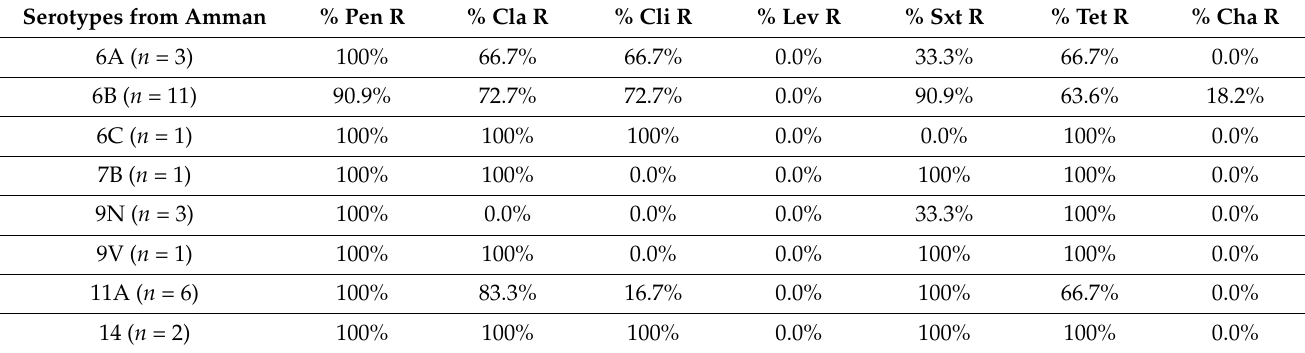
Table 5. Serotype-related antibiotic resistance to isolates from Table 5. S erotype-related antibiotic resistance to isolates from Amman.